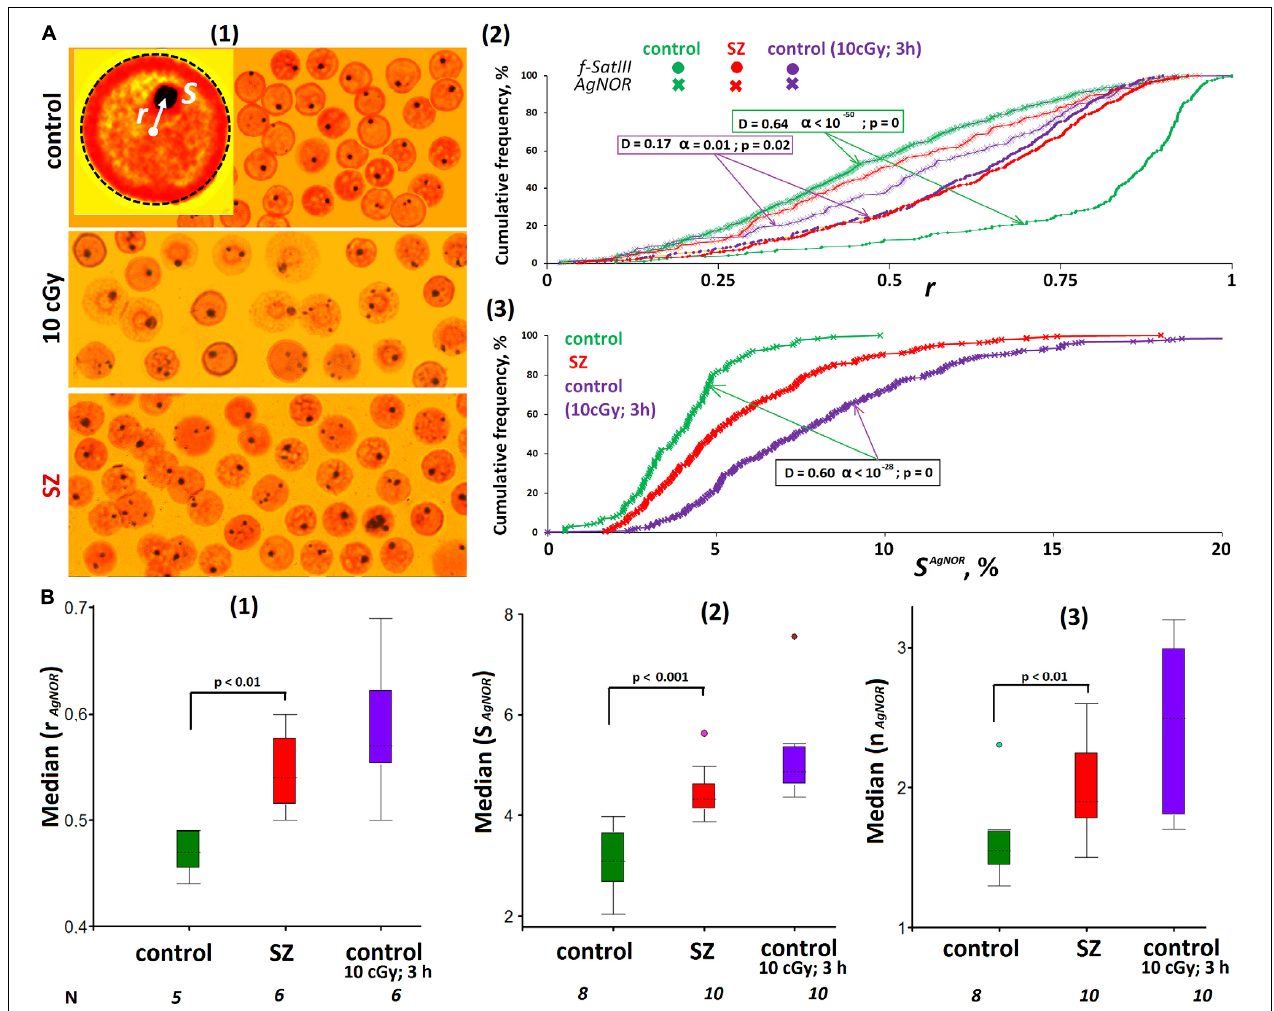
FIGURE 4 | ROS change the location and size of the nucleolus in lymphocyte. (A) (1) The example of Ag staining of the nucleolus (AgNOR). Gallery of the nuclei was formed from multiple photos. (2) Cumulative histograms of the frequency distribution of the Ag signals by the radius vector r (0: center of the nucleus) for intact, irradiated (10 cGy), and SZ lymphocytes. For comparison, the graph shows the data for the FISH signals of the same samples. (3) Cumulative histograms of the frequency distribution of the Ag signals by the total square S AgNOR for intact HC, irradiated HC (10 cGy), and SZ lymphocytes. The result is confirmed on five HC and five SZ samples. (B) (1) The values of the medians of the radius r (AgNOR) for the HC cells, for irradiated HC cells and for the SZ cells. (2) The values of the medians of the area S (AgNOR) for the groups. (3) The median of the AgNOR copy number for the